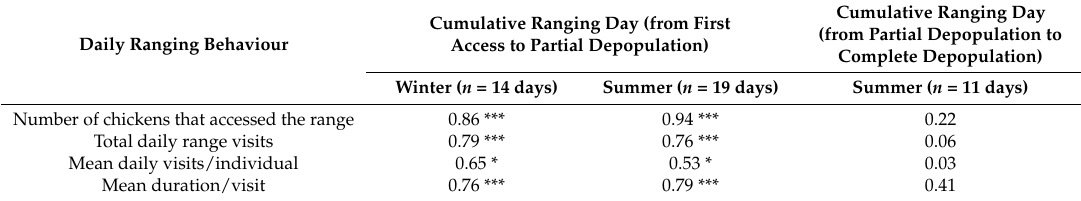
Table 1. Pearson’s partial correlation coefficients ( r ), controlling for flock, between the cumulative ranging day (relative to first availability) and daily ranging behaviour, before partial depopulation (summer and winter flocks) and between partial and complete depopulation (summer flocks only). Cumulative Ranging Day Cumulative Ranging Day (from First (from Partial Depopulation to Daily Ranging Behaviour Access to Partial Depopulation) Complete Depopulation) Winter ( n = 14 days) Summer ( n = 19 days) Summer ( n = 11 days) Number of chickens that accessed the